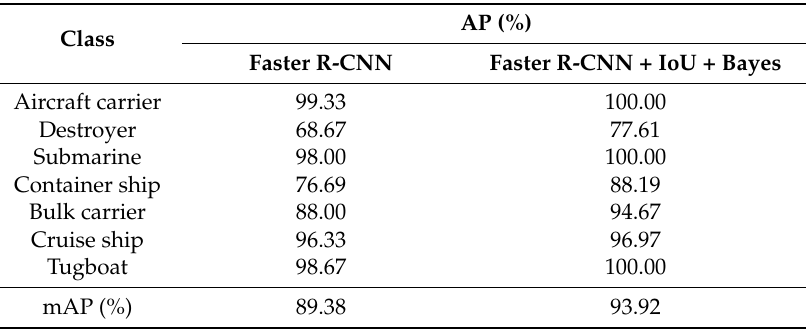
Table 5. Performance of ship detection on test videos.